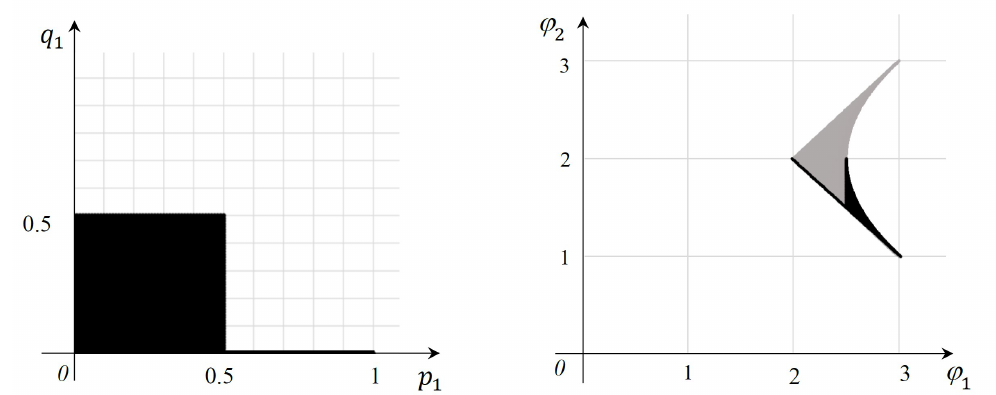
Figure 3. Game (14). The set of equilibrium outcomes R 0 in the plane of the first strategies’ compo- nents (on the left) and equilibrium values Z 0 (in bold) in the criterion space (on the right). Notice that ϕ 1 ( p , q ) and ϕ 2 ( p , q ) (i.e., G 2 ) increase in q 1 for all p 1 > 1/2.